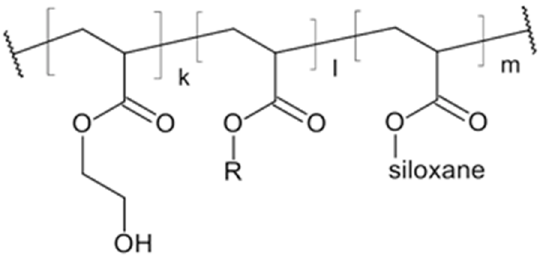
Figure 1. General chemical structural formula of the used silanized PUR coatings.